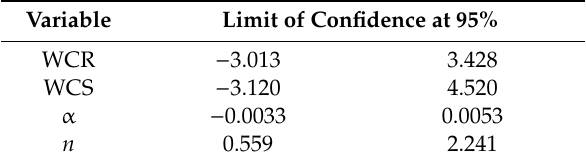
Table A1. The lower and upper confidence limits for optimized parameters in inverse